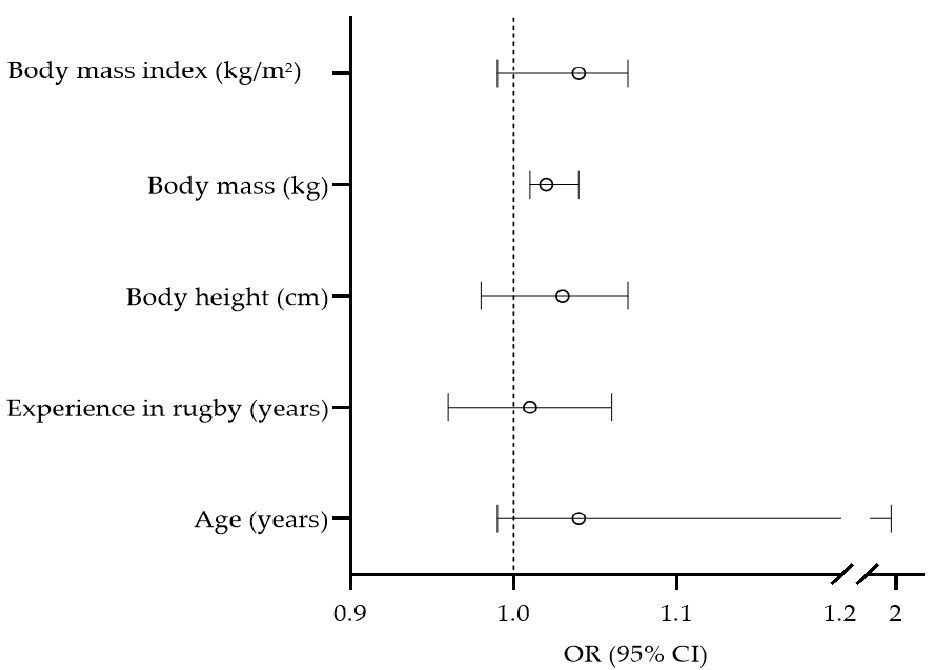
Figure 2. Univariate associations between sociodemographic and anthropometric variables with injury occurrence .